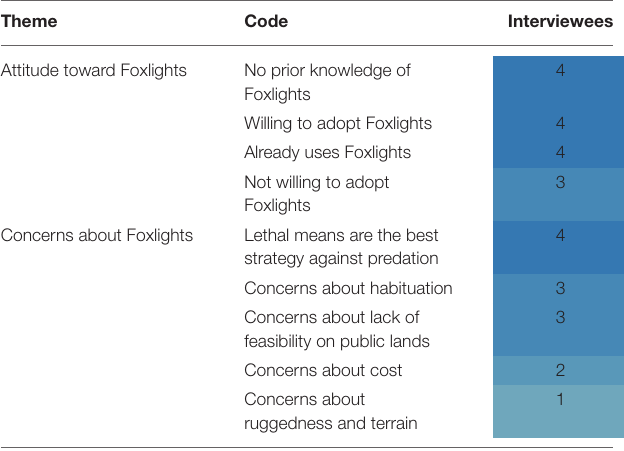
TABLE 1 | Producer attitudes toward Foxlights prior to seeing results of the